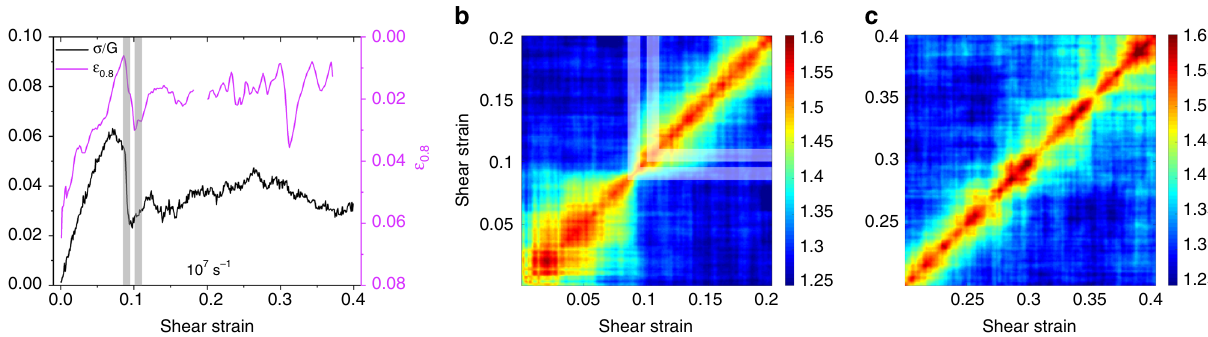
Fig. 7 Atomistic simulations reveal the origin of intermittent dynamics. a Normalized shear stress along with ε 0.8 momentary relaxation strains as a function of shear strain for a binary model glass strained at 10 7 s − 1 under simple shear. Note the inverted axis on the relaxation strain. b A two-strain correlation function from 0 to 0.2 in shear strain shows the transition from elastic to plastic fl ow at a shear strain of ca. 0.074, followed by fl uctuations in relaxation strain with plastic fl ow. c Shear strains from 0.2 to 0.4 show fl uctuating relaxation strains, decorrelation – recorrelation, as well as variation in contrast along the main diagonal. Similar results are found for a strain rate of 10 5 s − 1 , which are displayed in the SI